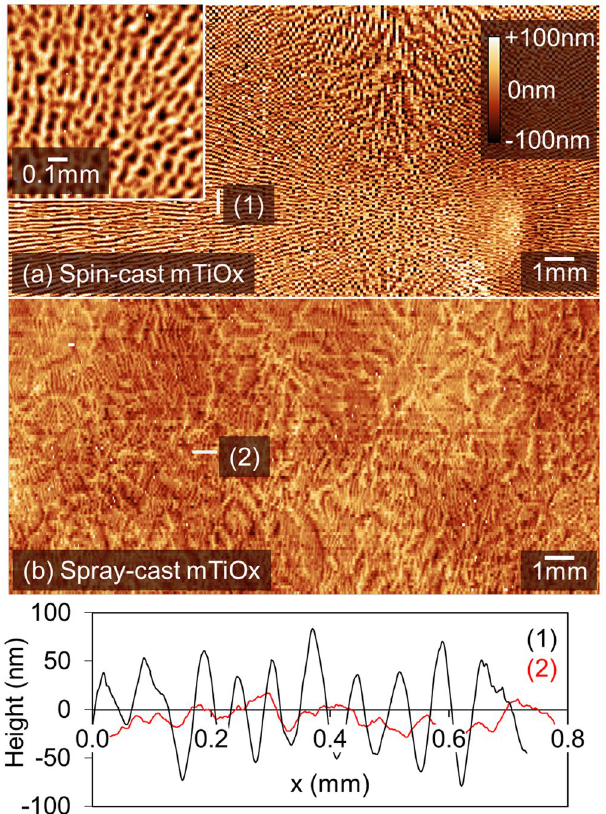
Figure 3. Topographic images of mTiOx prepared on a glass/FTO/cTiOx surface. Part ( a ) shows a spin-cast film with a high-resolution map shown in the inset. Part ( b ) shows surface topography of a spray-cast film, with line profiles determined from sections labelled (1) and (2) plotted using black (spin-cast) and red (spray-cast) lines shown as an inset. All images are plotted on the same colour